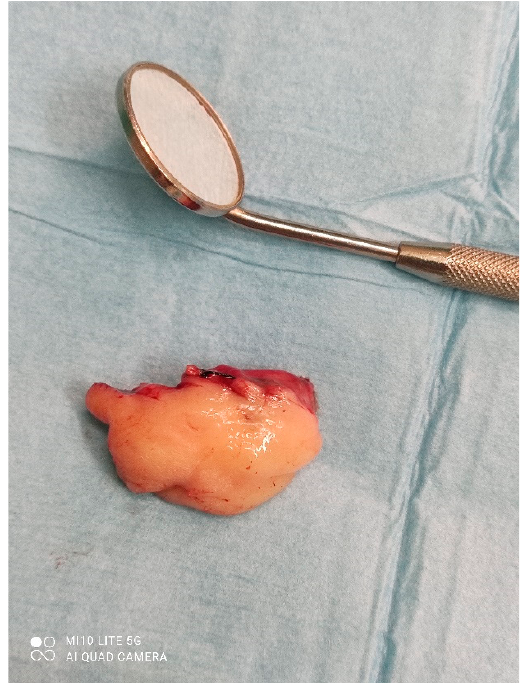
Figure 5. Size of the mass.